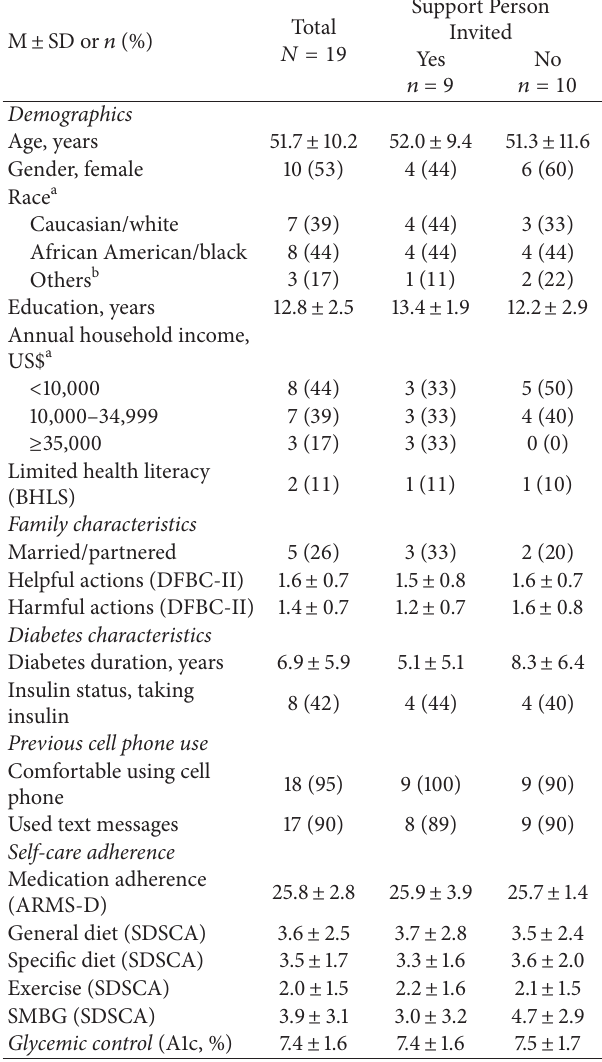
Table 2: Participant